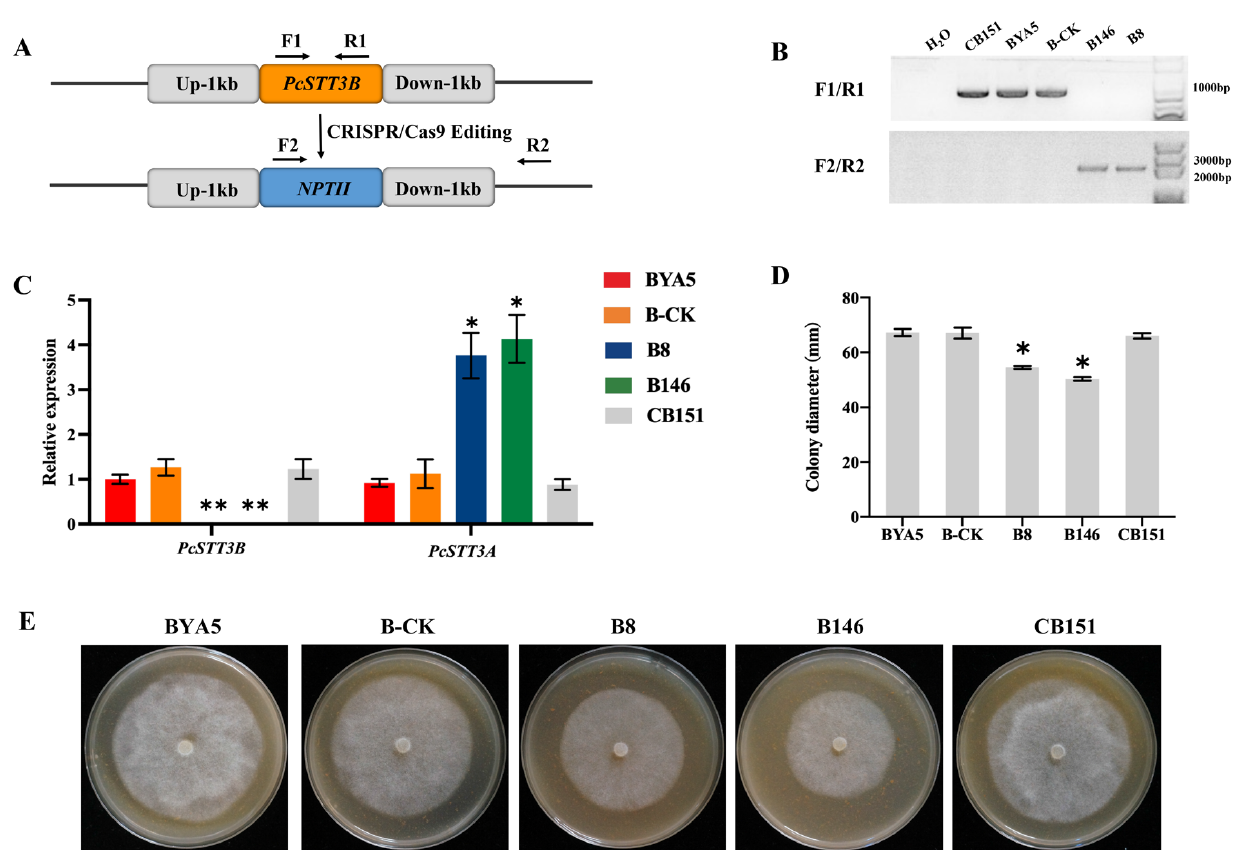
Figure 4. Roles of PcSTT3B to mycelial growth of P. capsici . ( A ) Diagram of HDR-mediated replace- ment of the PcSTT3B gene with the NPTII gene. The orange box represents the PcSTT3B gene, and the blue box represents the NPTII gene. ( B ) Verification of three PcSTT3B -deleted transformants using polymerase chain reaction (PCR). The Primers F1 and R1 were used to amplify the PcSTT3B gene. Primers F2 and R2 were used to amplify the NPTII gene. ( C ) Detection of PcSTT3A and PcSTT3B genes of different P. capsici strains were analyzed using reverse transcription quantitative real-time PCR (RT-qPCR). ( D ) Colony diameters of different P. capsici strains. ( E ) Colony morphology of P. capsici different strains cultured on the V8 agar for 3 days in darkness. Data represent the mean ± standard deviations from three biological repeats. Asterisks indicate significant deviations from the WT strain BYA5 (*, p < 0.05; **, p < 0.01).